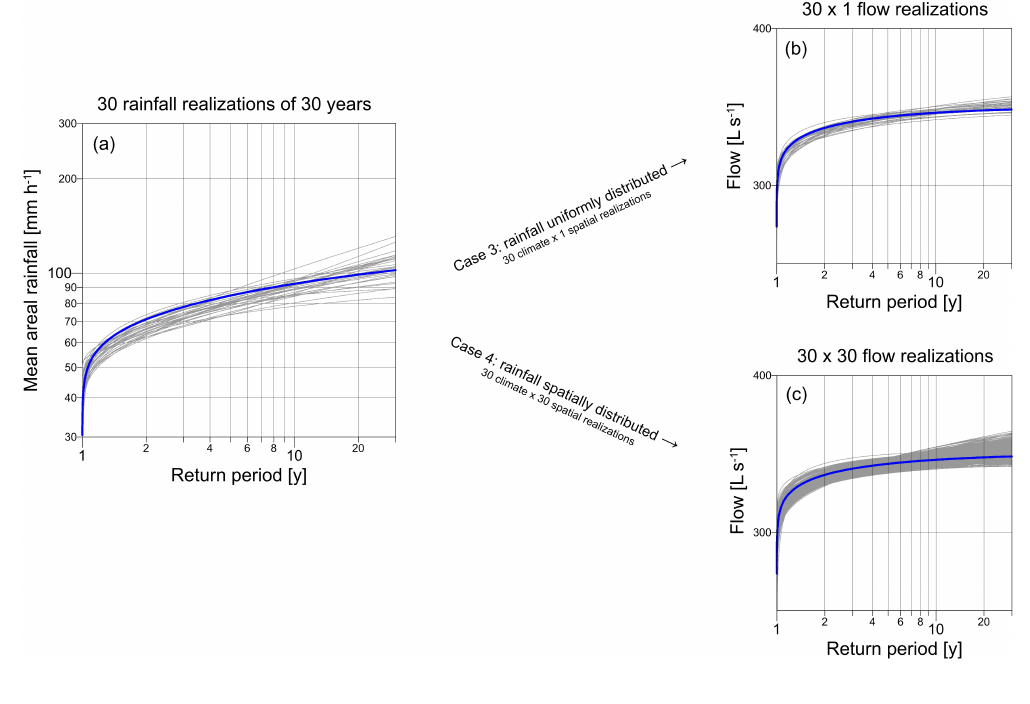
Figure 8. Same as Fig. 6, but for location B and cases 3 and 4.